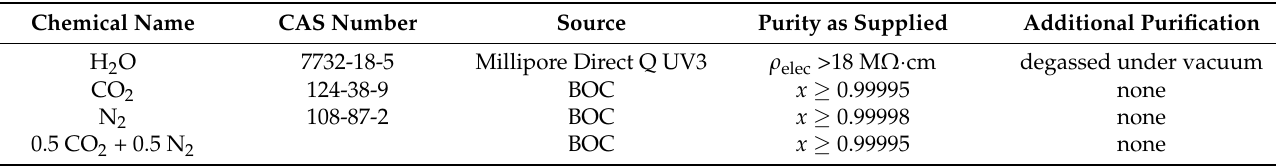
Table 3. Description of chemicals, where x denotes mole fraction, and ρ elec denotes electrical resistivity at T = 298 K.